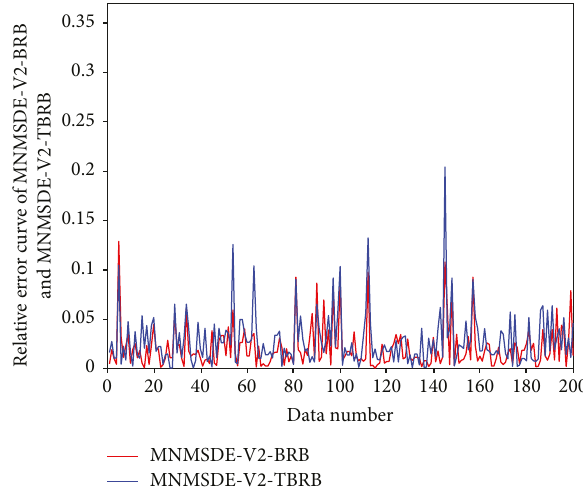
Figure 14: The relative error of MNMSDE_V1-BRB and MNMSDE_V1-TBRB.